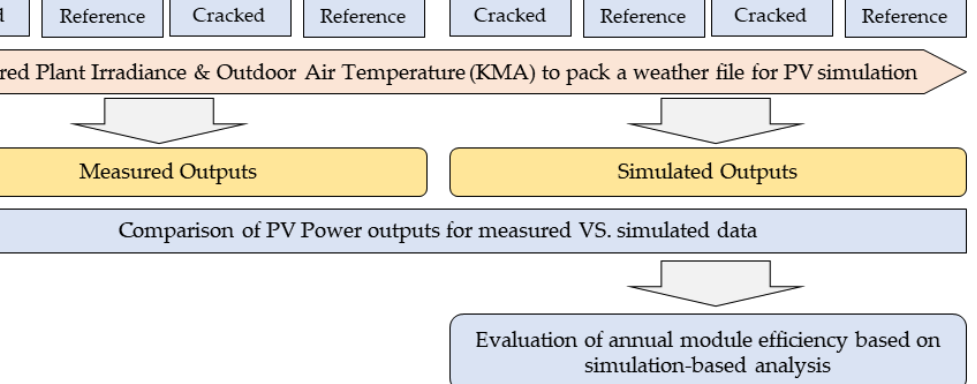
Figure 7. Flowchart of data analysis for the comparative study.